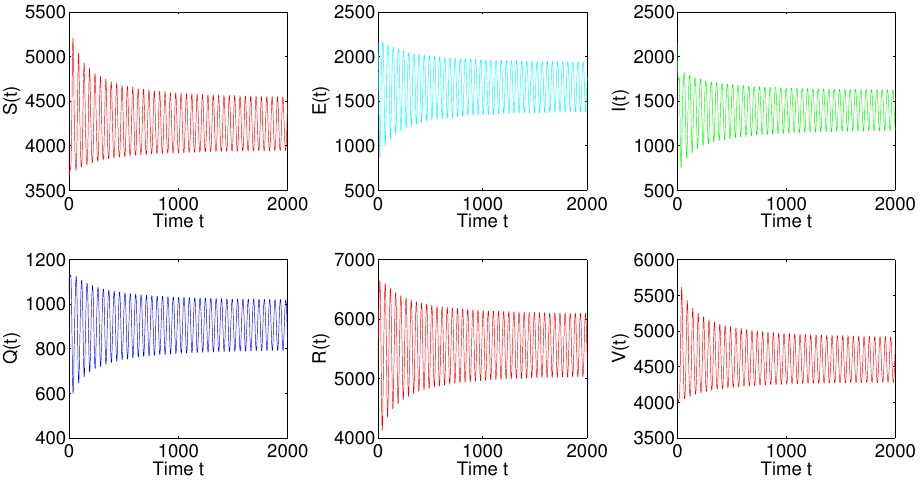
Figure 2. Time plots of S , E , I , Q , R and V with τ = 13.75 > τ 0 = 13.1047.